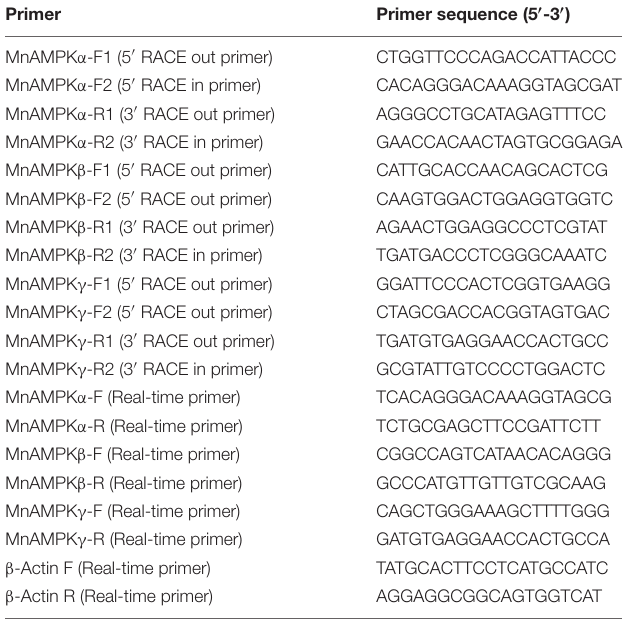
TABLE 1 | Primers used in this study.